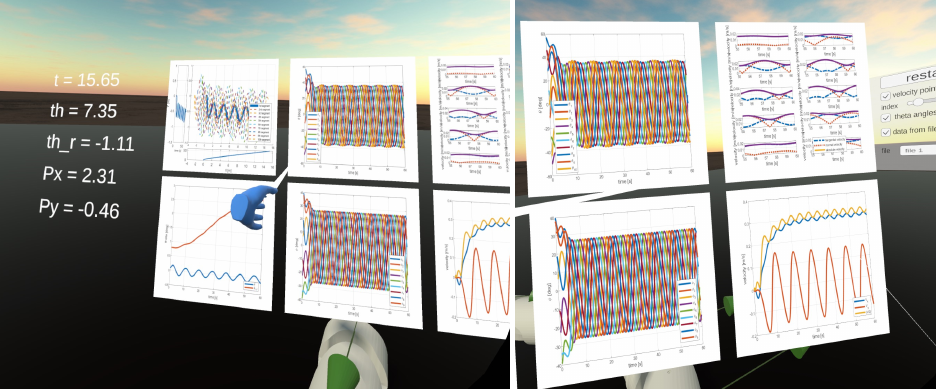
Figure 7. Screen from VR application showing a panel with simulation parameters and plots gener- ated in